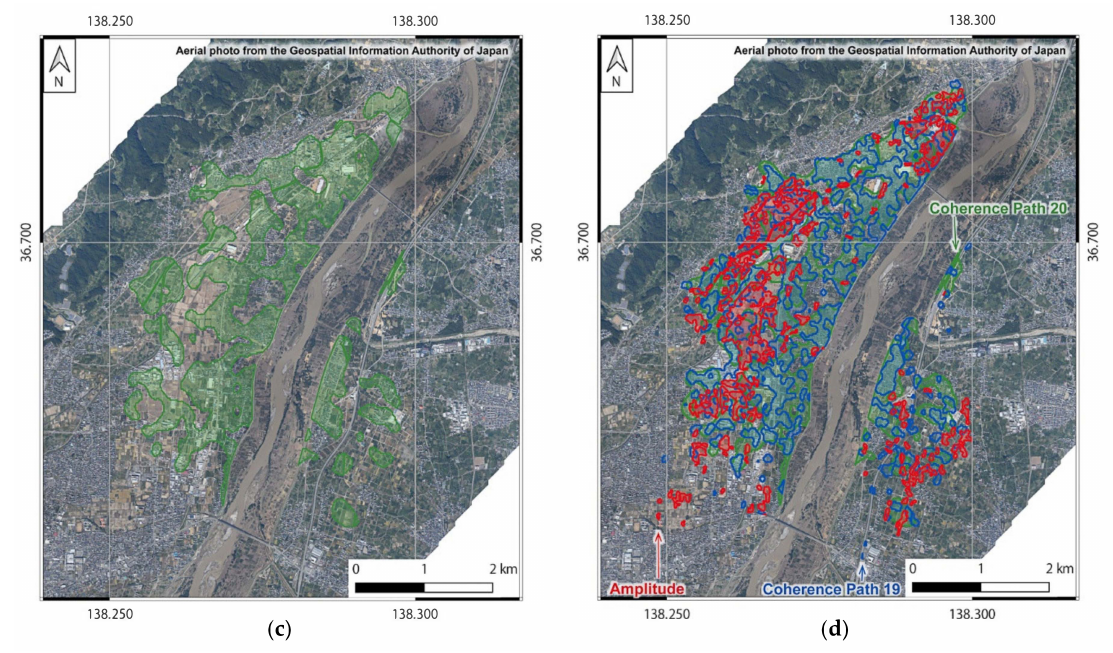
Figure 6. Comparison of the detection results for multi-temporal ( a ) intensity only, ( b ) coherence only (P19–P20), ( c ) coherence only (P20–P20), and ( d ) overlay of all intensity and coherence